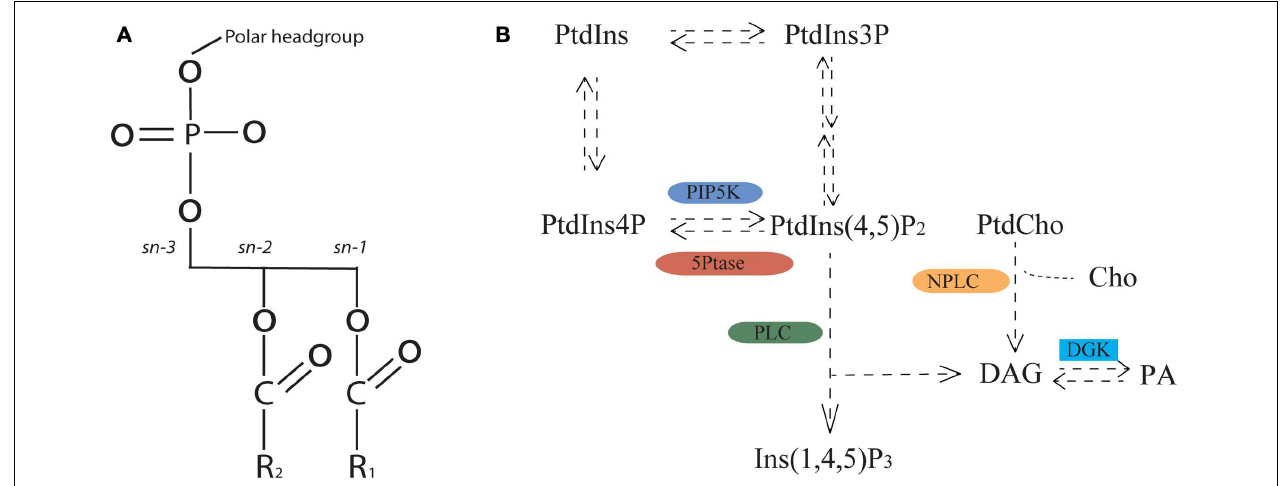
FIGURE 2 | Phosphoglycerolipid structure and biosynthetic pathway. (A) Phosphoglycerolipid structure containing glycerol backbone, polar headgroup and fatty acids (represented by R1 and R2). Polar headgroup refers to choline, serine, ethanolamine or inositol. (B) Simplified view of the phosphoglycerolipid biosynthetic pathway. PtdIns, phosphatidylinositol; PtdIns3P, phosphatidylinositol 3-phosphate; PtdInsP(4,5)P 2 , phosphatidylinositol 4,5-bisphosphate; PtdIns4P, phosphatidylinositol 4-phosphate; PtdCho, phosphatidylcholine; Cho, choline; DAG, diacylglycerol; PA: phosphatidic acid; Ins(1,4,5)P 3 , inositol 1,4,5 triphosphate; PIP5K, PtdIns4P-5-KINASE; 5PTase, PHOSPHATIDYLINOSITOL 5 (cid:48) PHOSPHATASE; PLC, PHOSPHOLIPASE C; NPC, NON-SPECIFIC PHOSPHOLIPASE C; DGK, DIACYLGLYCEROL